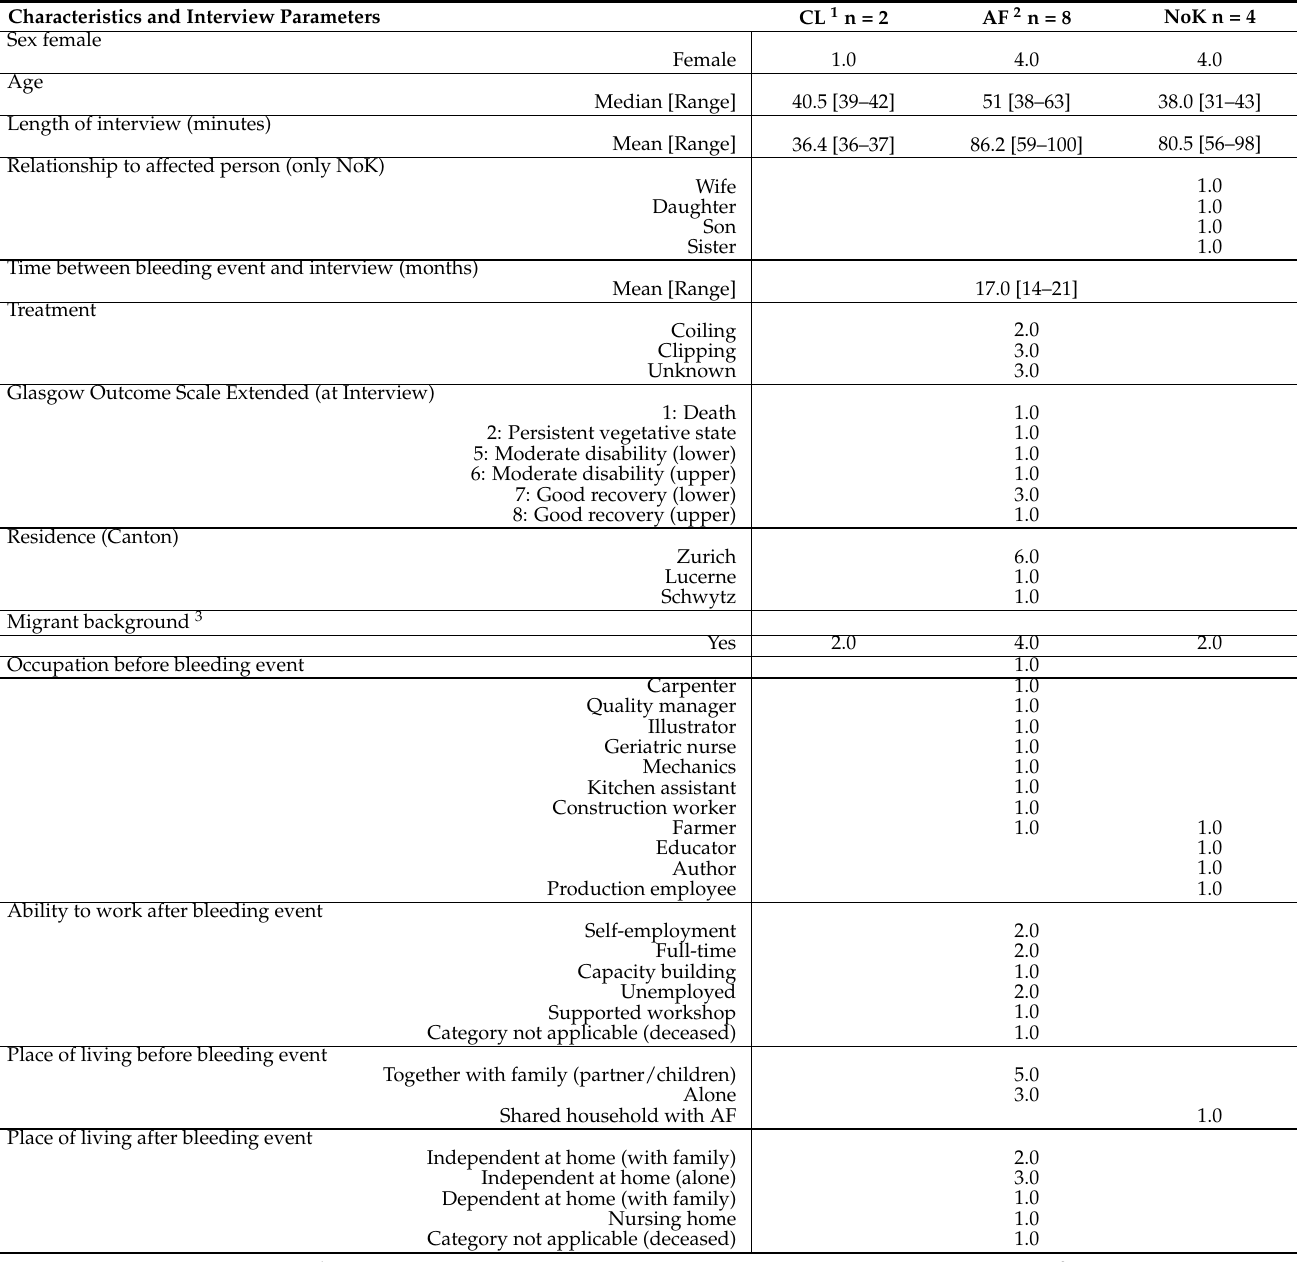
Table 2. Characteristics of interview